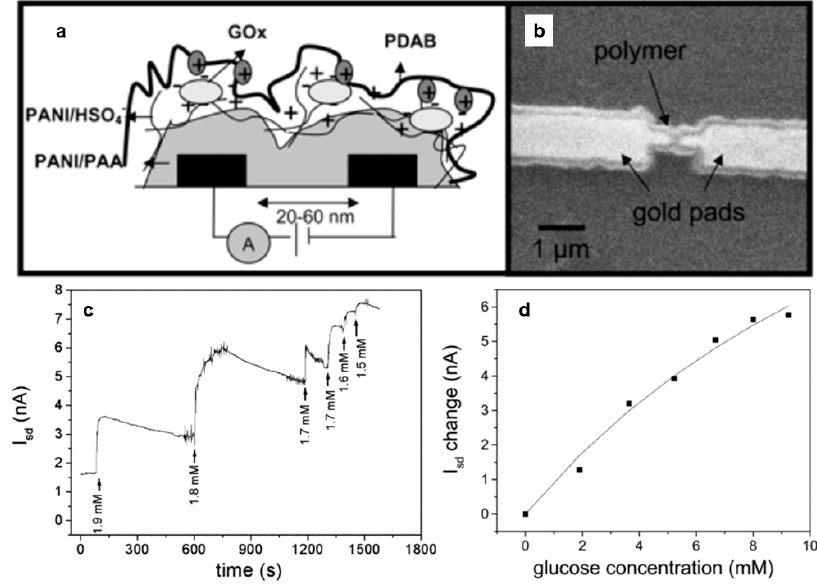
Figure 10. ( a ) Schematic illustration of sensor design. PANI is electrochemically deposited across the 20–60 nm gap between gold electrodes. Then, GOx is immobilized on the PANI surface. ( b ) Scanning electron micrograph of the sensor. ( c ) Drain current changes in response to successive 1 µL additions of 40 mM glucose. E g = 35 mV vs. saturated calomel electrode (SCE) in 20 µL McIlvaine buffer, 0.5 M Na 2 SO 4 at pH 5. ( d ) Corresponding calibration plot of drain current change vs. glucose concentration [50]. Reprinted with permission from E. S. Forzani, H. Zhang, L. A. Nagahara, I. Amlani, R. Tsui, and N. Tao,